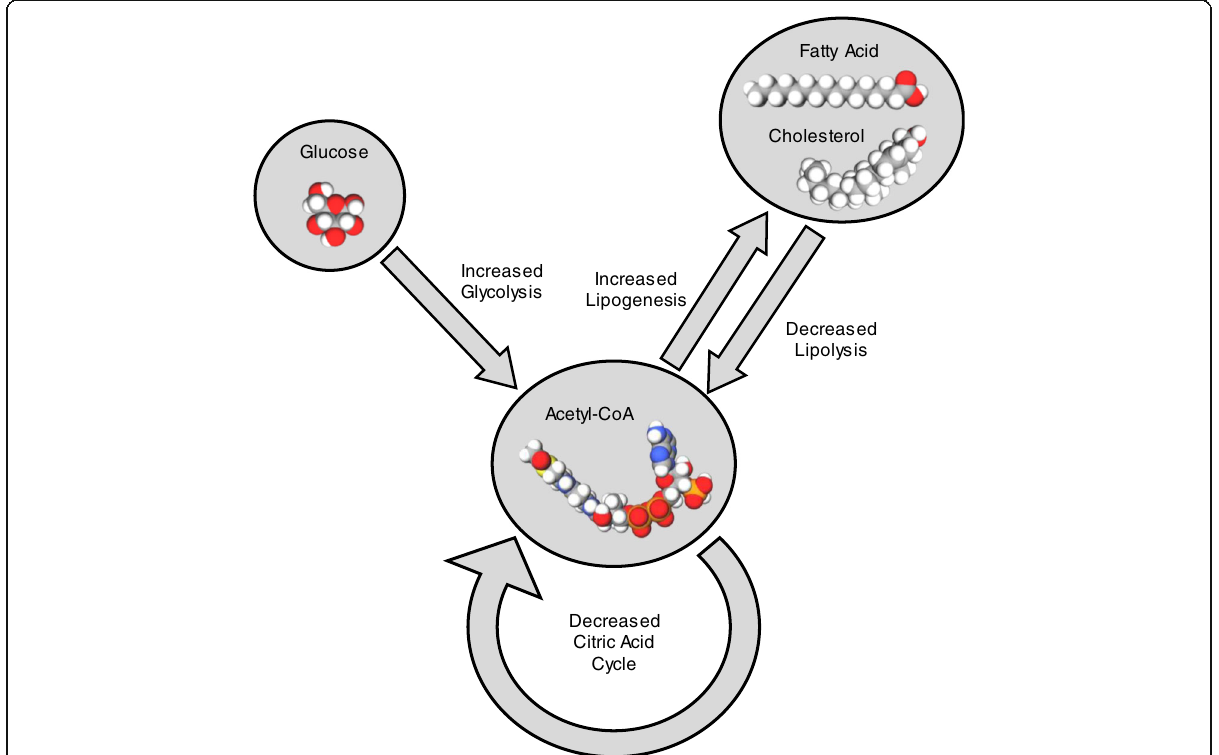
Fig. 2 A general diagram showing the physiological basis responsible for the NPC1 gene-nutrient interaction that promotes weight gain and susceptibility to obesity. Mouse model tissues (liver and adipose) and fibroblasts grown in culture indicate (i) increased glycolysis (oxidation of glucose and conversion to pyruvate in the cytoplasm), (ii) decreased oxidative metabolism (conversion of pyruvate to acetyl-CoA and condensation with oxaloacetate to produce citrate in the mitochondria), (iii) increased lipogenesis pathway (transport of citrate from the mitochondria and conversion to acetyl-CoA and malonyl-CoA for lipid (cholesterol and fatty acid) synthesis in the cytoplasm), and (iv) decreased lipolysis pathway (transport of fatty acid from the cytoplasm and conversion of fatty acid to acetyl-CoA in the